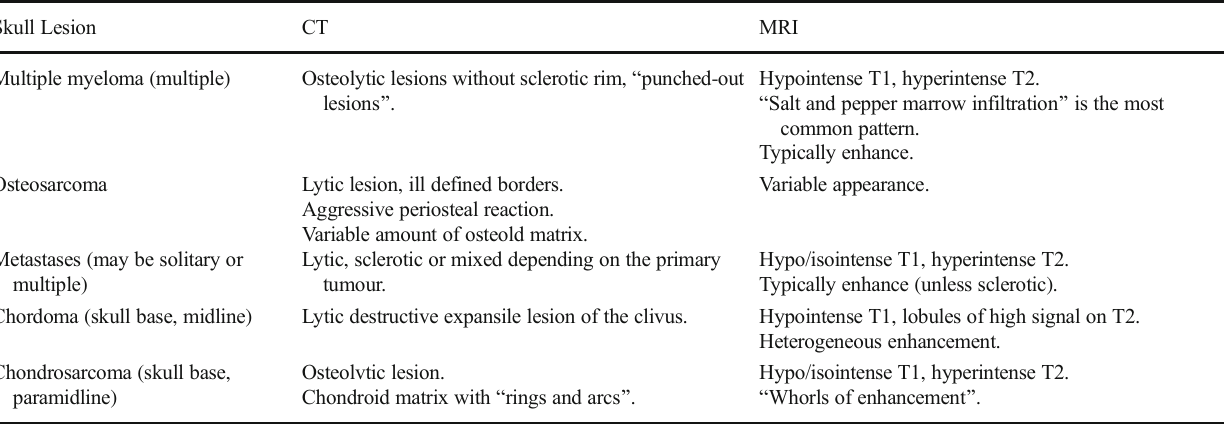
Salient features of malignant skull lesions on CT and MRI Skull Lesion